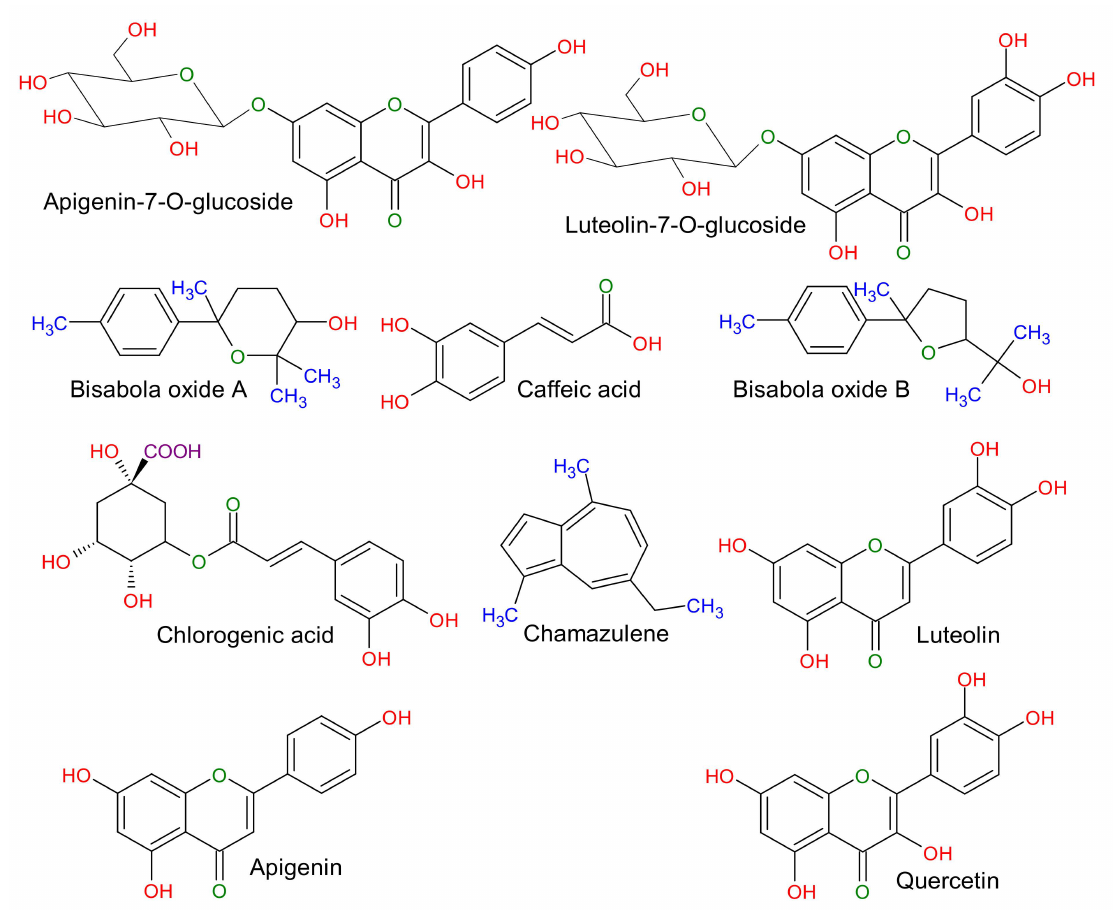
Figure 6. Various chemical constituents of a herb extract ( Matricaria chamomilla